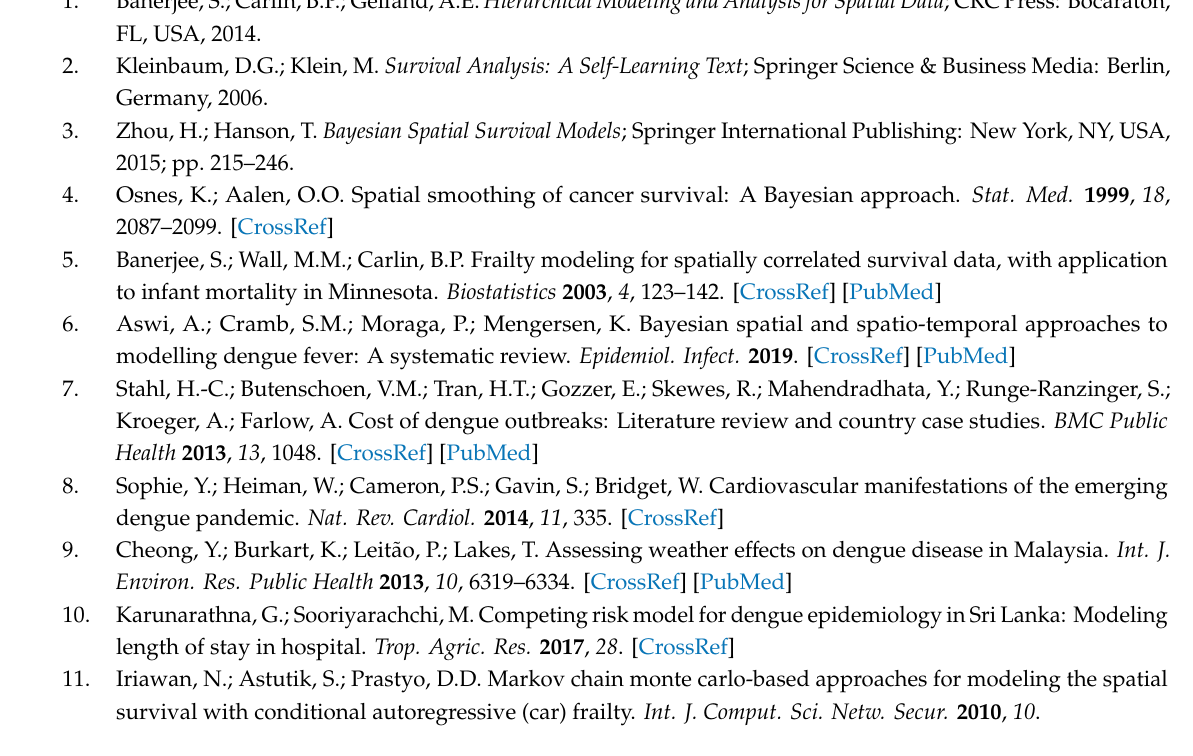
Table S1: The proportional hazard assumption test using Schoenfeld residuals, Code S1: R code for Bayesian Weibull spatial survival model using Leroux CAR prior, Code S2: R code for Bayesian Cox spatial survival model using Leroux CAR